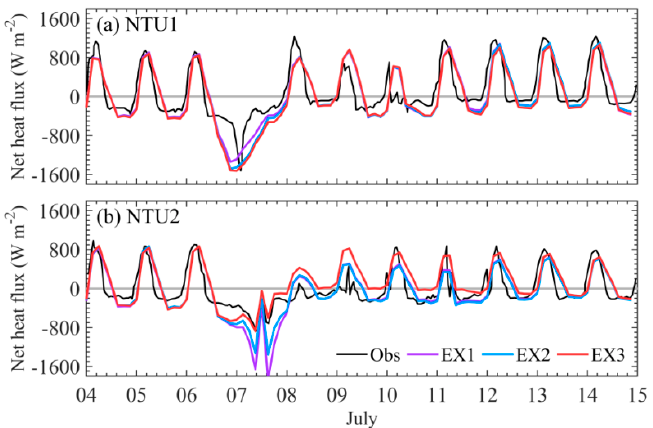
Figure 8. Comparisons between modeled and observed surface heat flux at buoy station NUT1 and